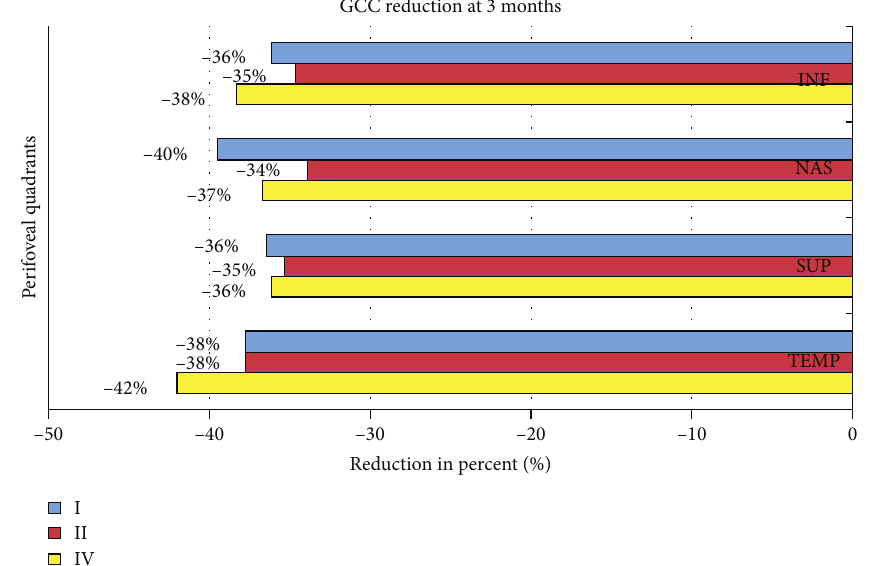
Figure 7: Reduction in thickness of the singular perifoveal quadrants during